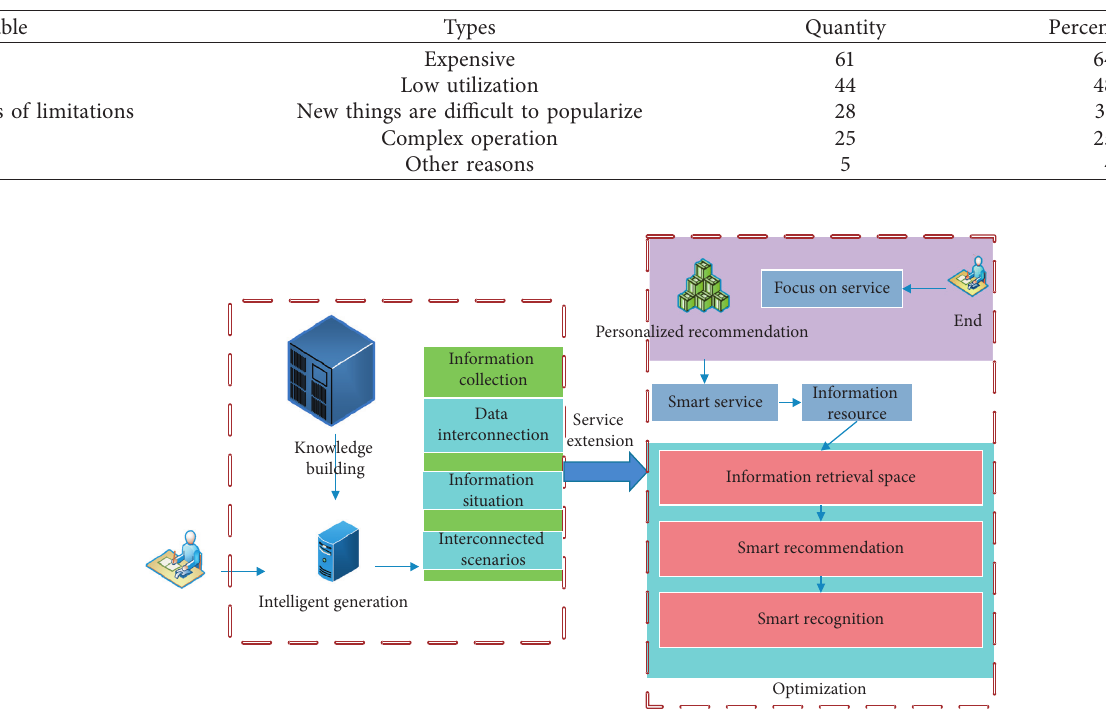
Figure 4: Goal-oriented diagram of the knowledge service extension of the smart library.